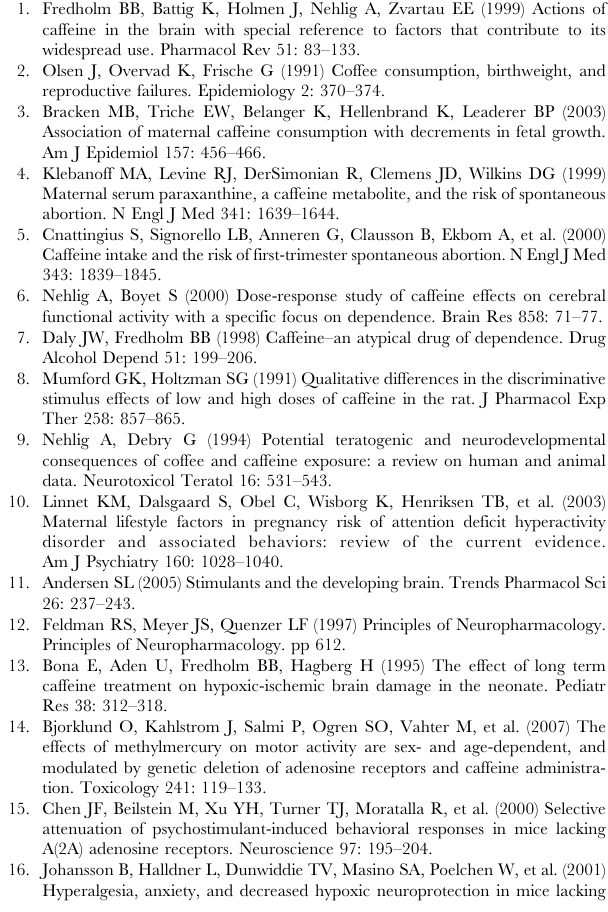
Figure S1 Rotarod measurements.Analysis of the rotarod performance in adult WT and A 1 R Hz male (A) and female (B) mice that received perinatally 0.3 g/l caffeine or tap water. Fall latencies (mean 6 S.E.M.) were analyzed by Student’s t test